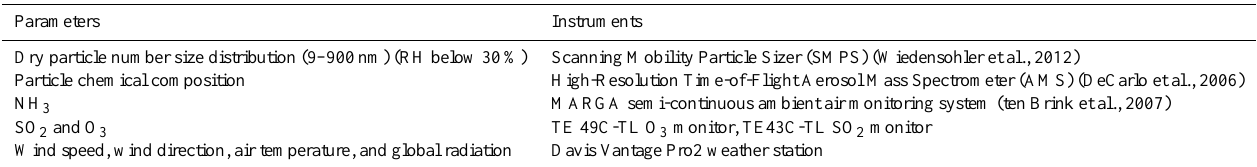
Table 1. Atmospheric parameters and instrumentation from the field experiment HCCT-2010 that are used in this study. All measurements were taken from the Goldlauter station except global radiation, which was taken from the Schm¨ucke (summit) station.